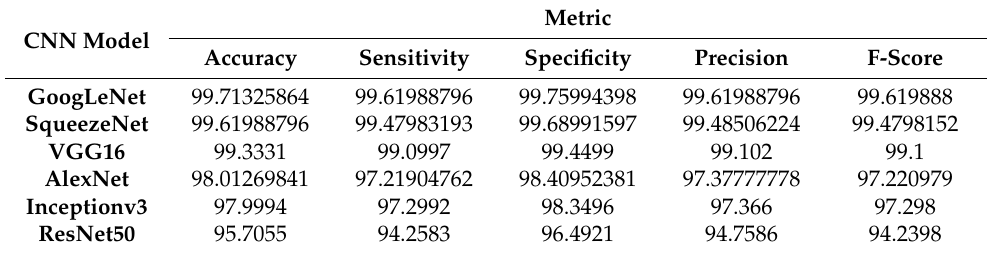
Table 8. Results of the evaluation metrics and CNN